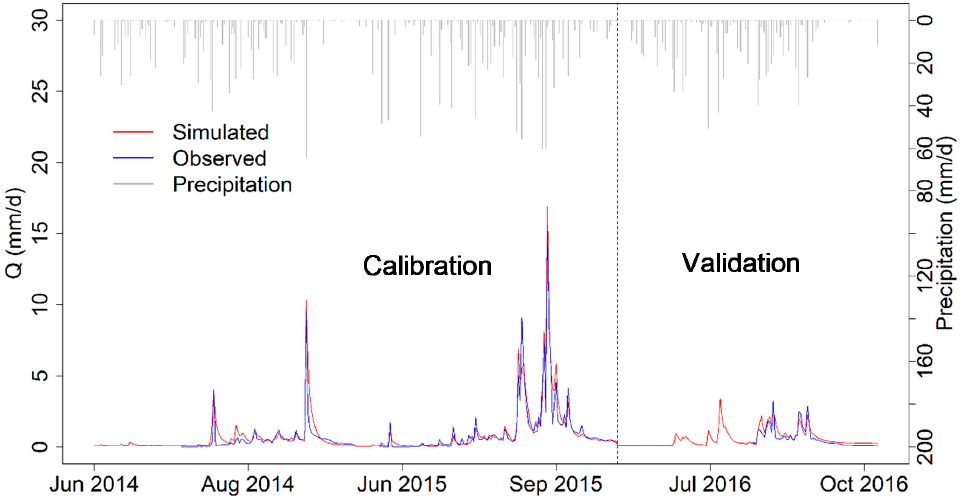
Figure 8. Comparison of the simulated and observed hydrographs for the outlet (Bankandi-Lo ffi ng). The vertical dash line separates the calibration period from the validation period.